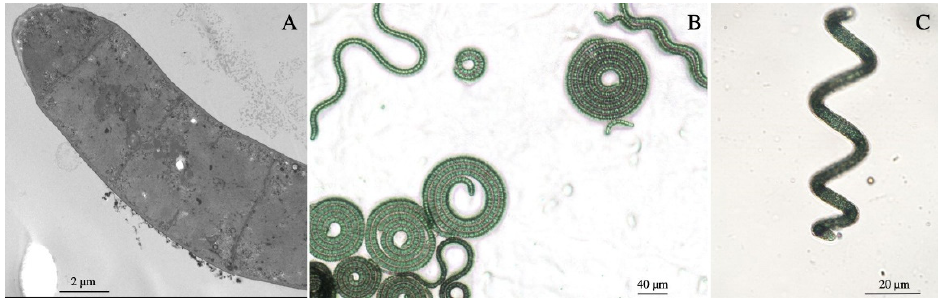
Figure 1. Images of Arthrospira sp. O9.13F. Photographs were taken by TEM ( A ) and light microscopy of Arthrospira culture grown on solid ( B ) and liquid Zarrouk medium ( C